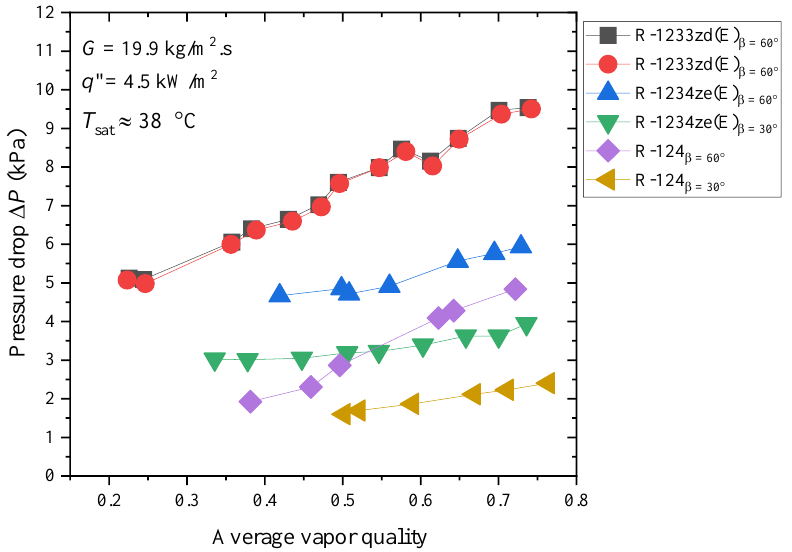
Figure 13. Pressure drops of low-GWP refrigerants inside the plate heat exchanger with different chevron angles. Rectangular and solid connected line presents the Known et al. [66] and Shon et al. [67] study respectively, triangular upward and downward solid connected lines presents the Jung et al. [68] study, star, and triangular backward solid connected line presents the Ko et al. [69] study.